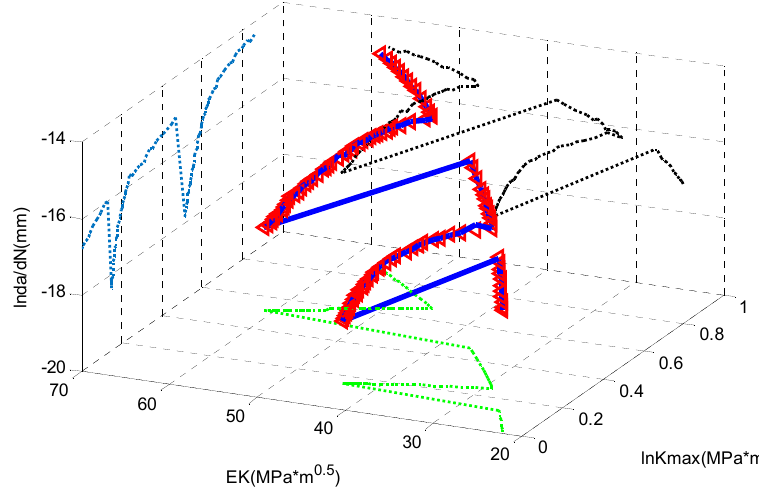
Figure 22. The fitting vs. the experimental data for 350 WT steel.